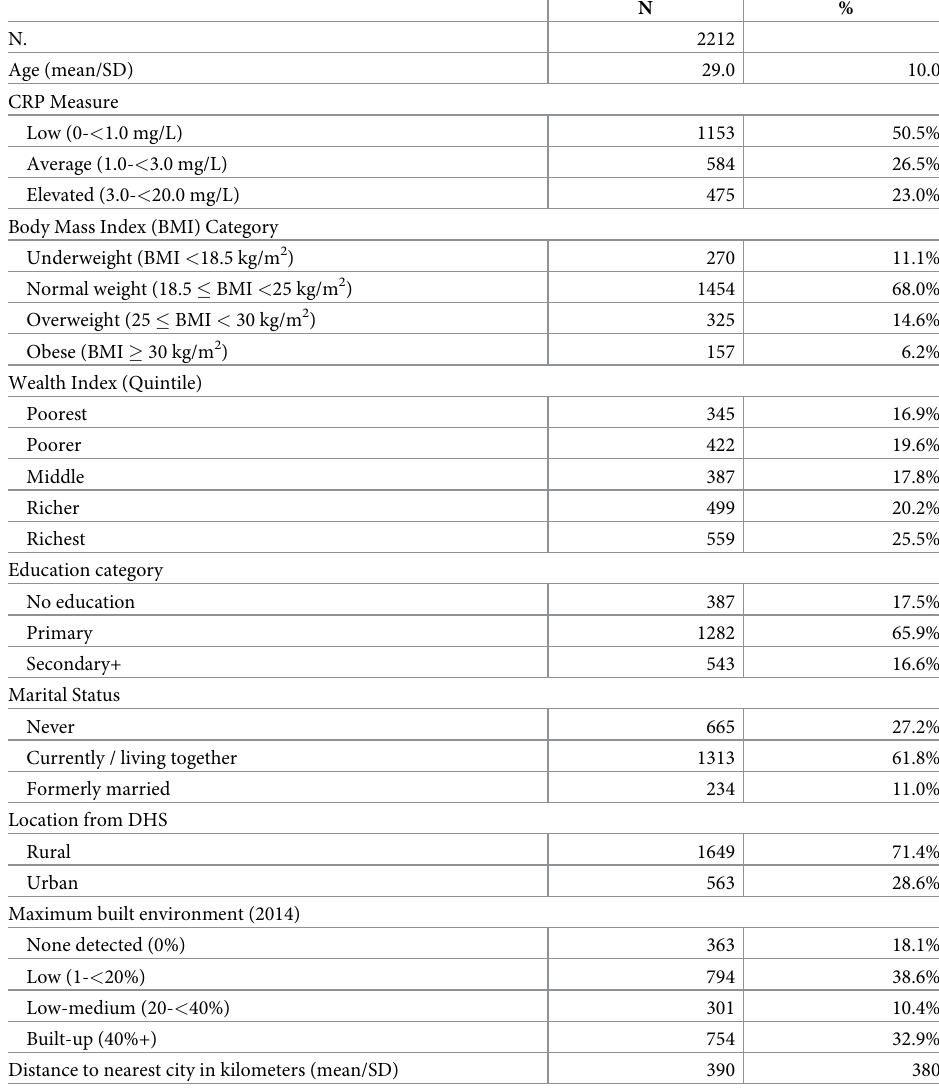
Table 1. Characteristics of participants included in the study.